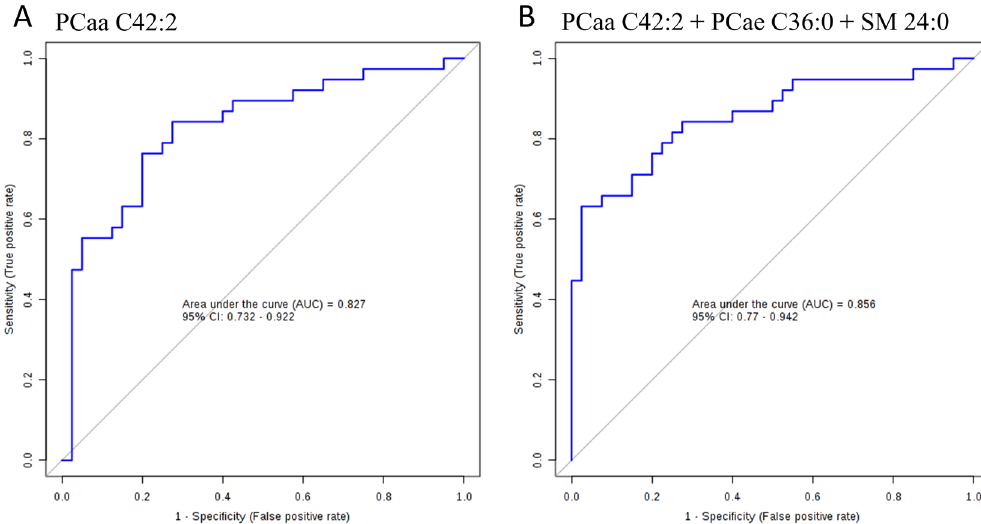
Figure 3. Receiver operating characteristics (ROC) curves analysis. ROC curve models of ( A ) PCaa C24:2 and ( B ) combined metabolites of PCaa C42:2 + PCae C36:0 + SM 24:0 to discriminate GBS patients from the